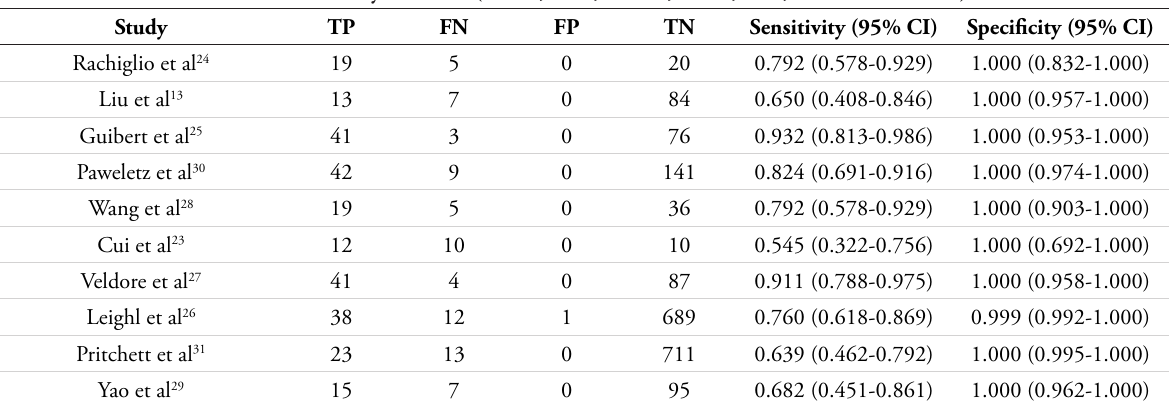
Table 3. Data Extracted from Each Study Included (EGFR, ALK, ROS-1, BRAF, RET, and MET exon 14)